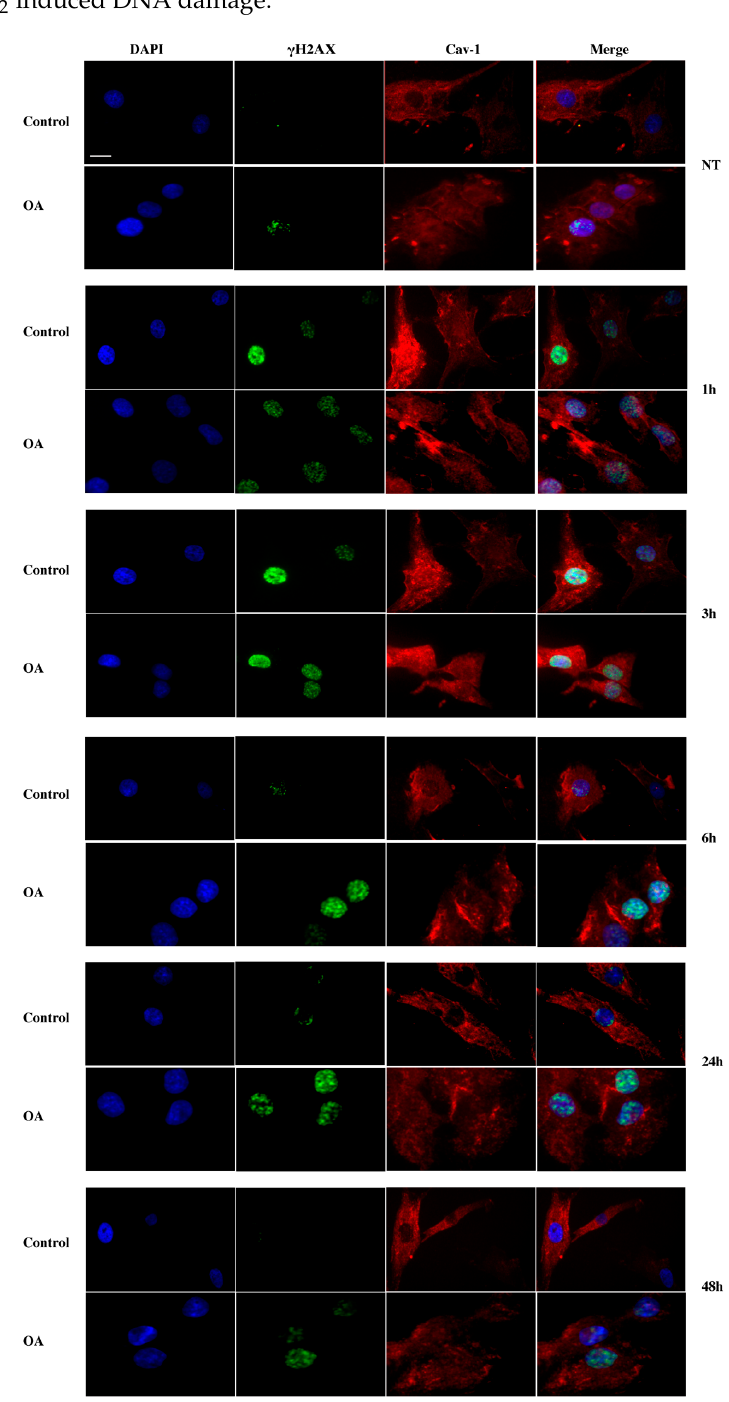
Figure 5. Translocations of caveolin-1 in and out of the nucleus in response to DNA damage appearance and restoration. Characteristic images of control and OA chondrocytes where caveolin-1 localization was evaluated by staining with anti-cav-1 antibody and the appropriate secondary antibody (red) under normal conditions (No Treatment—NT) and at 1, 3, 6, 24, and 48 h after being treated with H 2 O 2 . DNA damage was also assessed by staining with the γ H2AX antibody and the appropriate secondary antibody (green). Nuclei were stained with DAPI (blue). Images were captured with the 40 × objective lens of the fluorescent microscope used. Scale bar 25 µ